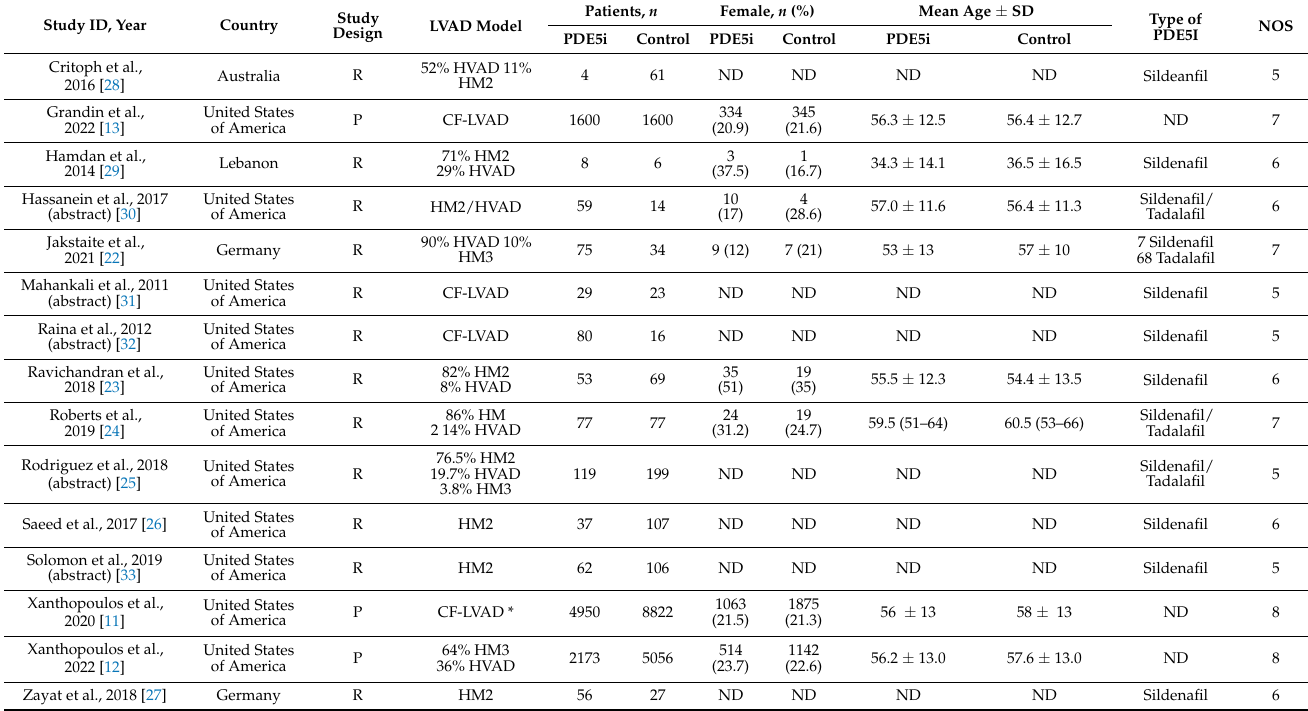
Figure 1. PDE5i vs. control treatment for patients with LVAD: flow diagram.